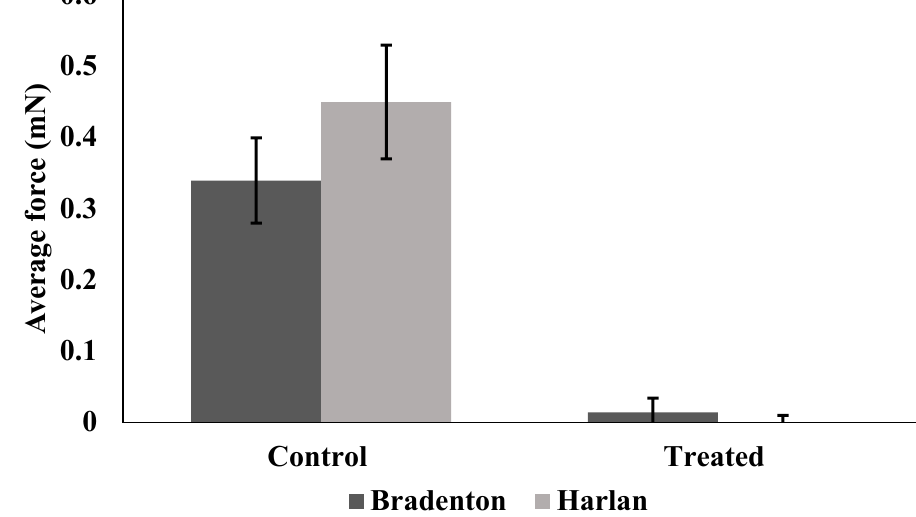
Figure 5. Average amount of force generated by Bradenton and Harlan strain bed bugs when gripping a surface with tarsi following no exposure to lufenuron (Control) or exposure to sub-lethal doses of lufenuron (Treated).